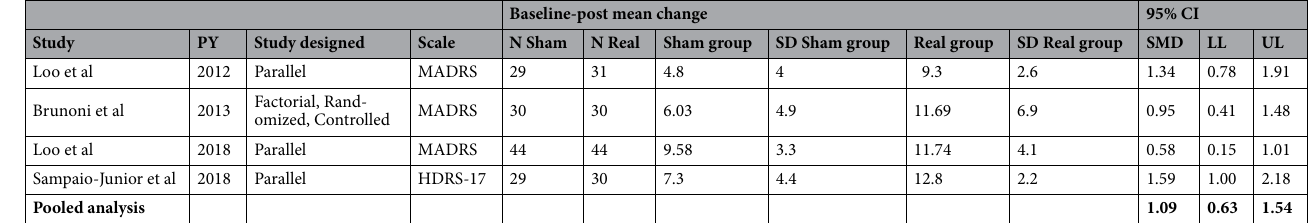
Table 5. Depression. Real Vs Sham. SD = Standard Deviation.SMD = Standardized Mean Difference. CI = Confidence Interval. LL = Lower Limit. UL = Upper